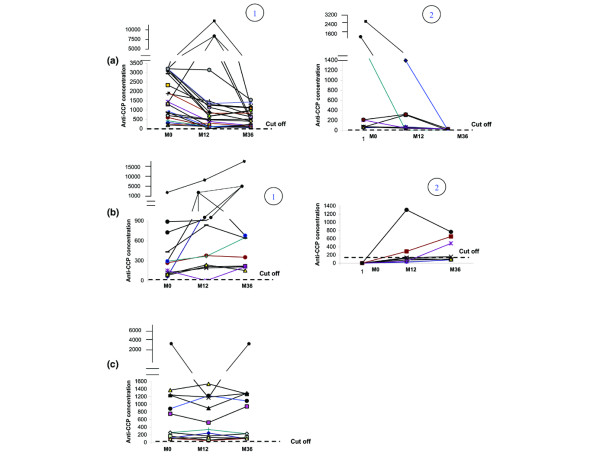
Anti-CCP2 concentrations at baseline (month 0 (M0)), 1 year (M12) and 3 years (M36) of follow-up according to (a) decreasing concentrations (panel 1 and 2), (b) increasing concentrations (panel 1 and 2) or (c) steady concentrations. Patients with transition from positive to negative and negative to positive are shown on panel 2 in (a, b).